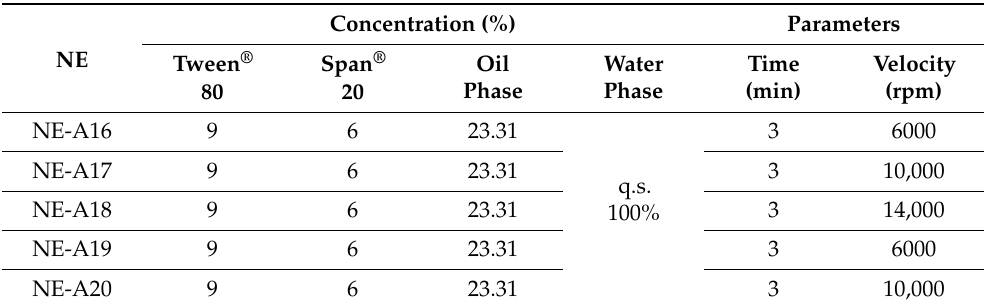
Table 4. Composition of NEs, variation of the BO concentration (NE-A19 and NE-A20) and Ultra- Turrax ® speed (NE-A16 to